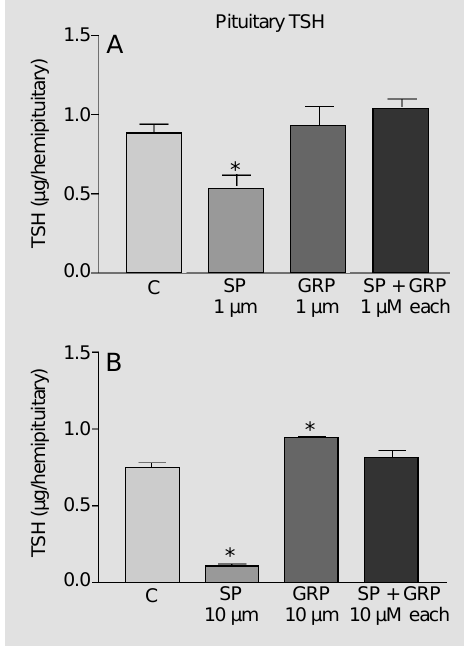
Figure 2 - Thyrotropin (TSH) con- tent of hemipituitaries incubated in the presence of medium alone (control, C) or 1 µM (Panel A) or 10 µM (Panel B) gastrin-releas- ing peptide (GRP), substance P (SP) or both. Data are reported as means ± SEM for 3 experi- ments. *P<0.05 compared to control (ANOVA followed by Newman-Keuls multiple com- parison